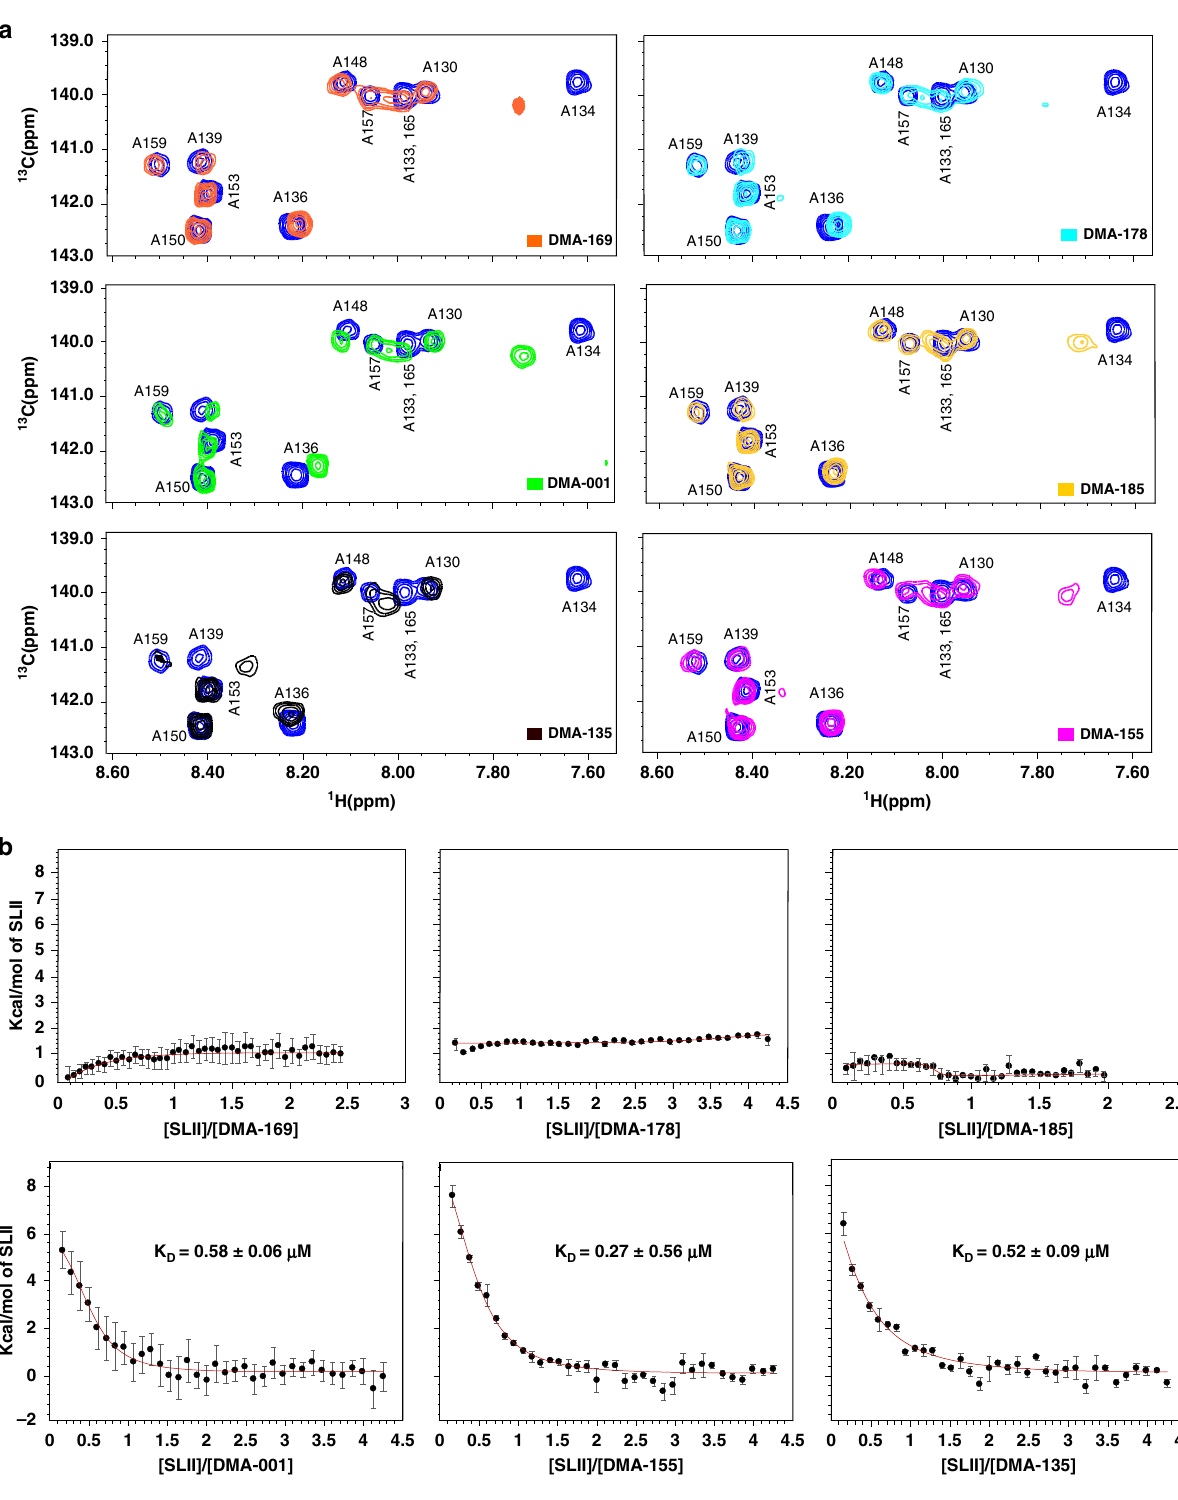
concentrations in the range of 0.001 – 1000 µ M , and after 2 days the activity of Renilla (RLuc) and Fire fl y (FLuc) were measured. Only DMA-135 showed activity in the assay, and it attenuated IRES-dependent translation (FLuc) in a dose-dependent manner, without having any signi fi cant effects on cap-dependent (RLuc) translation (Fig. 3b). At 0.1 μ M DMA-135, FLuc activity declined by ~10% relative to the control. FLuc activity declined by 50%